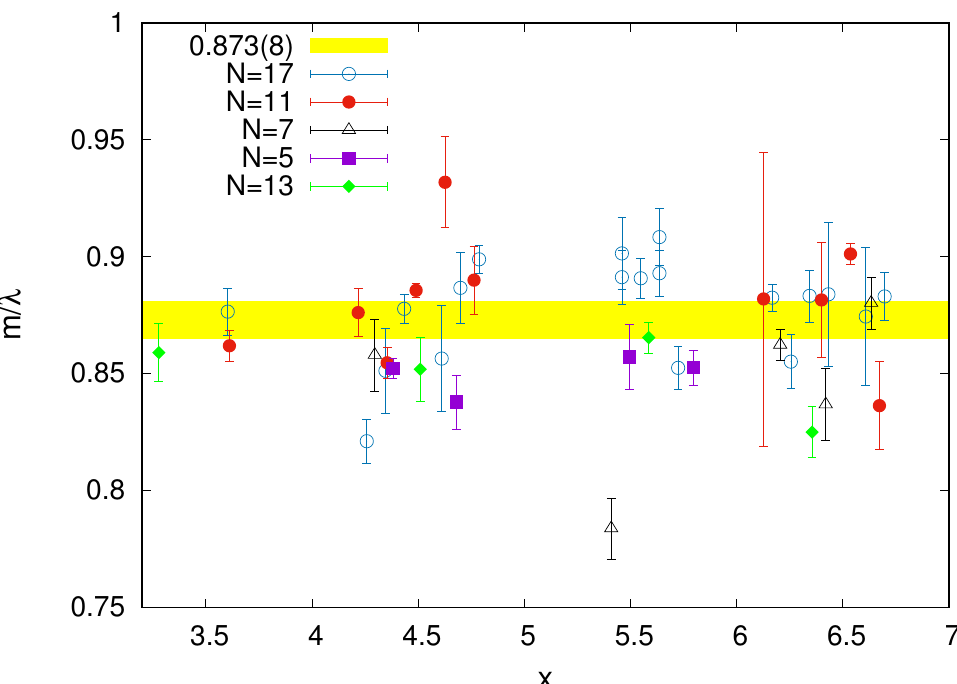
Figure 12. Large x -dependence of the glueball mass computed with the selection criterion dis- cussed in section